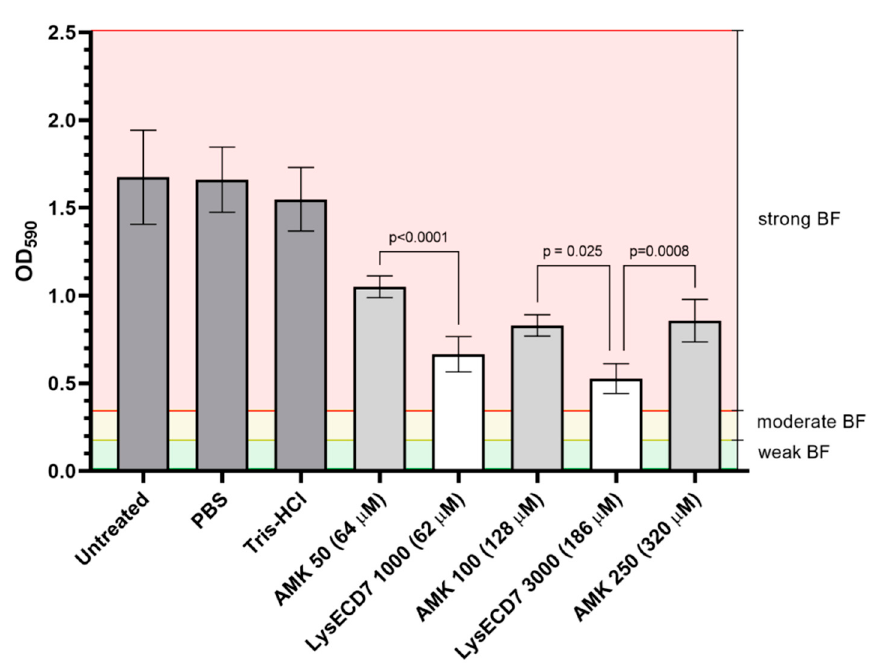
Figure 3. Antibacterial activity of the LysECD7 and amikacin (AMK) against mature BF measured after 43 h of culture incubation of K. pneumoniae strain Ts 141-14; Untreated—untreated BF; PBS—BF treated with Phosphate-Buffered Saline; Tris-HCl—BF treated with 20 mM Tris-HCl buffer; AMK 50 (64 µM)—mature BF treated with 50 µg/mL AMK; LysECD7 1000 (62 µM)—mature BF treated with 1000 µg/mL LysECD7; AMK 100 (128 µM)—mature BF treated with 100 µg/mL AMK; LysECD7 3000 (186 µM)—mature BF treated with 3000 µg/mL LysECD7; AMK 250 (320 µM)—mature BF treated with 250 µg/mL AMK. Weak, moderate and strong BF were estimated according to Stepanovic et al., 2007 [21]. Data are shown as mean ± standard deviation. Significant differences with the AMK groups are shown as p -values (one-way ANOVA with Dunnett’s multiple comparisons test). Differences between treatments and controls were significant ( p < 0.0001).